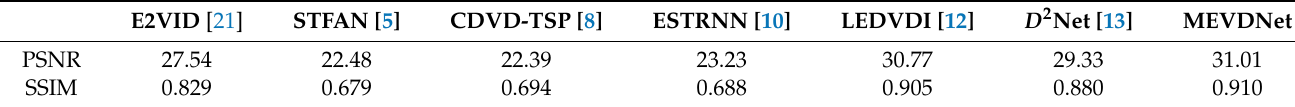
Table 3. Quantitative results of video deblurring using the HQF real